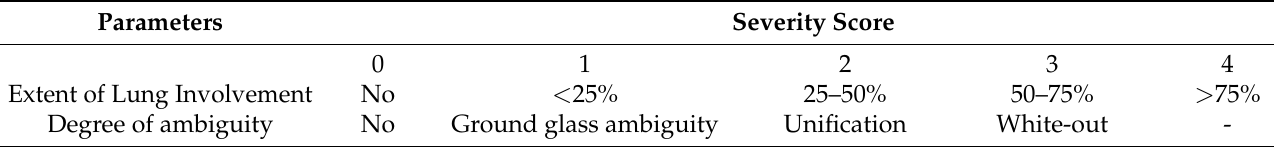
Figure 4. A presentation of a predicted severity scores for COVID-19 chest X-ray scans while using the DenseNet model [48]. Table 2. COVID-19 severity stages using a score-based